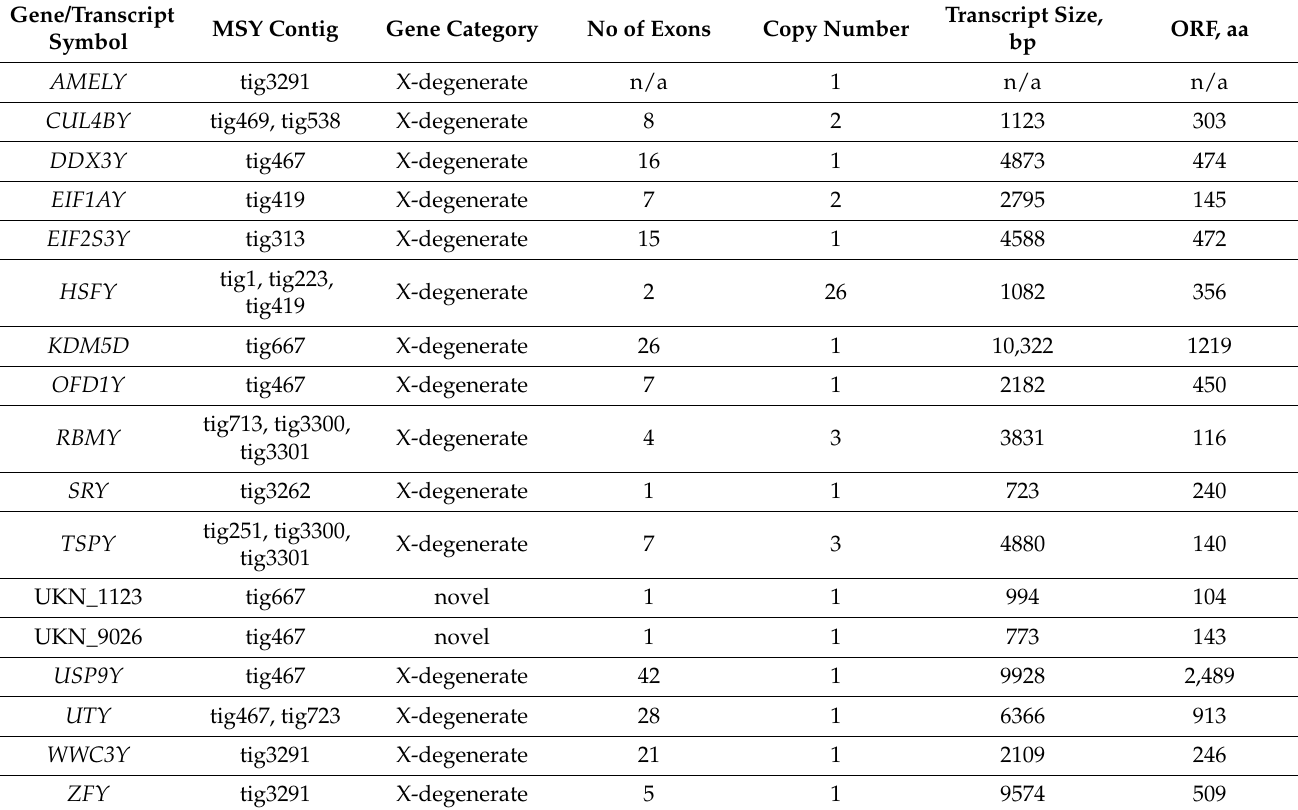
Table 3. Gene catalogue of the 4.48 Mb alpaca Y